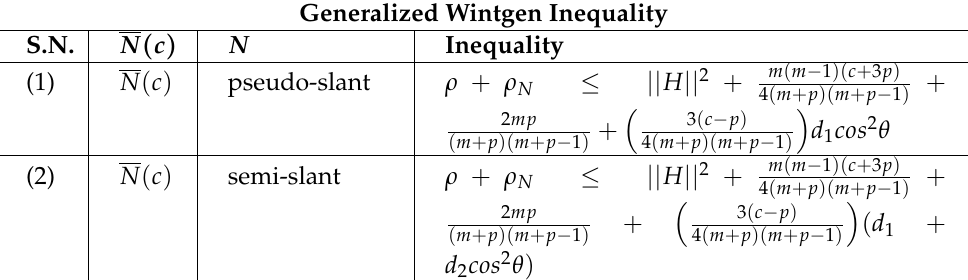
Generalized Wintgen Inequality